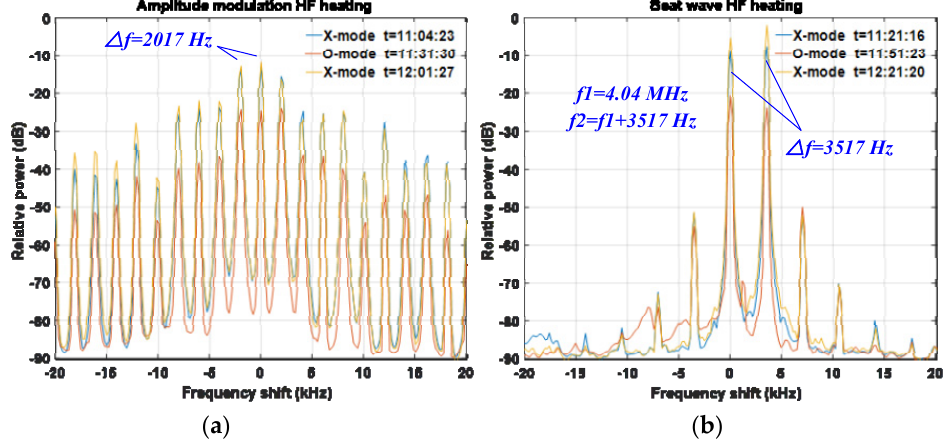
Figure 2. SEE frequency spectra of HF scattered signals from the EISCAT HF transmitter. The center frequency is 4.04 MHz. ( a ) Amplitude modulation approach; ( b ) Beat-wave modulation approach.